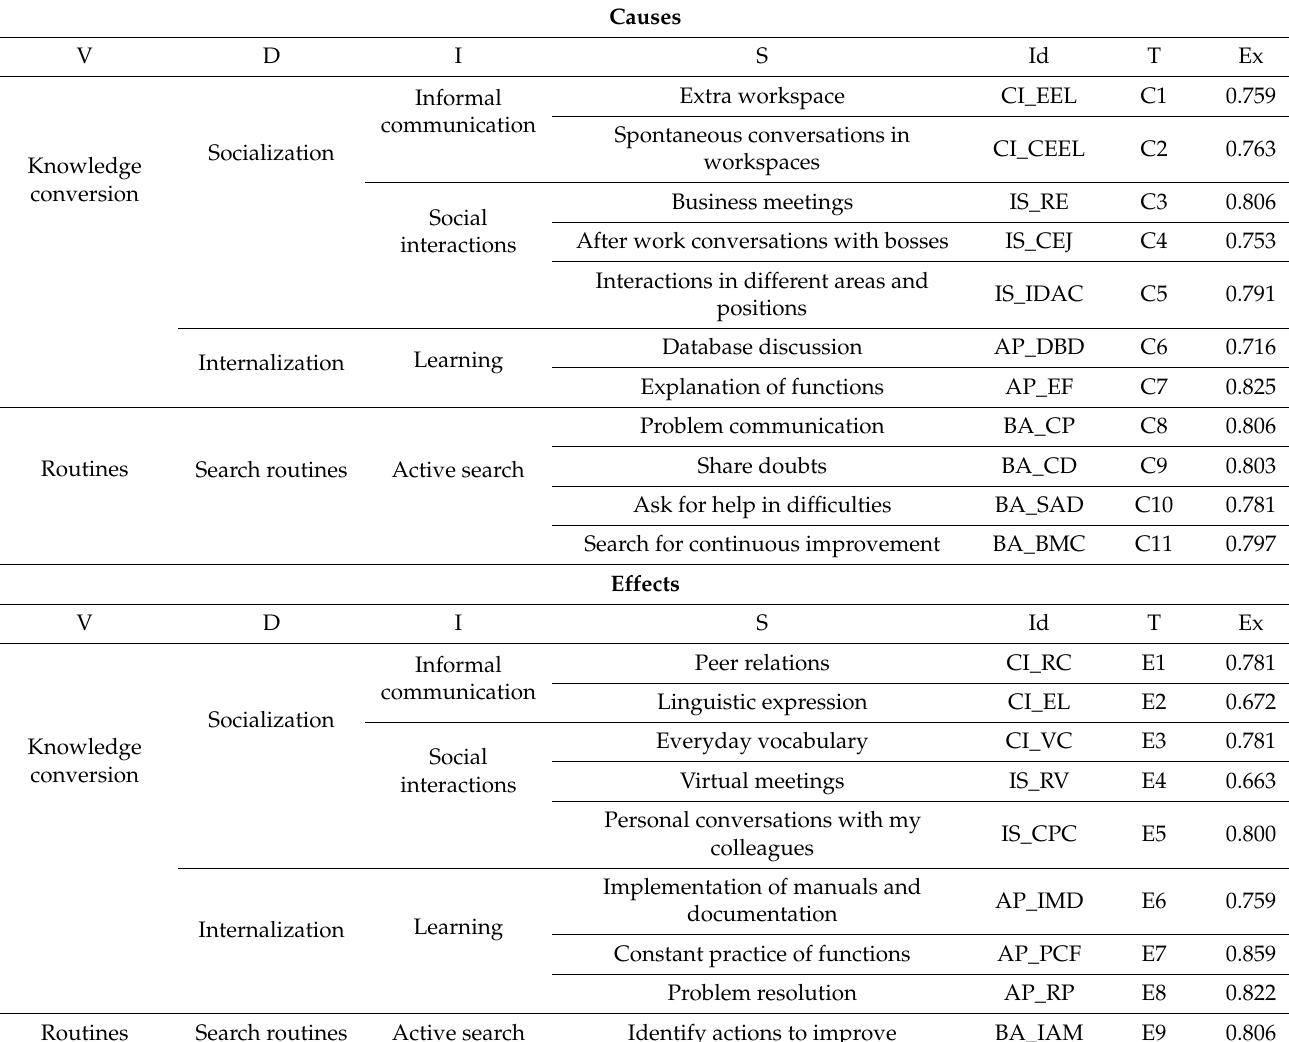
Table 10. Causes and effects of knowledge